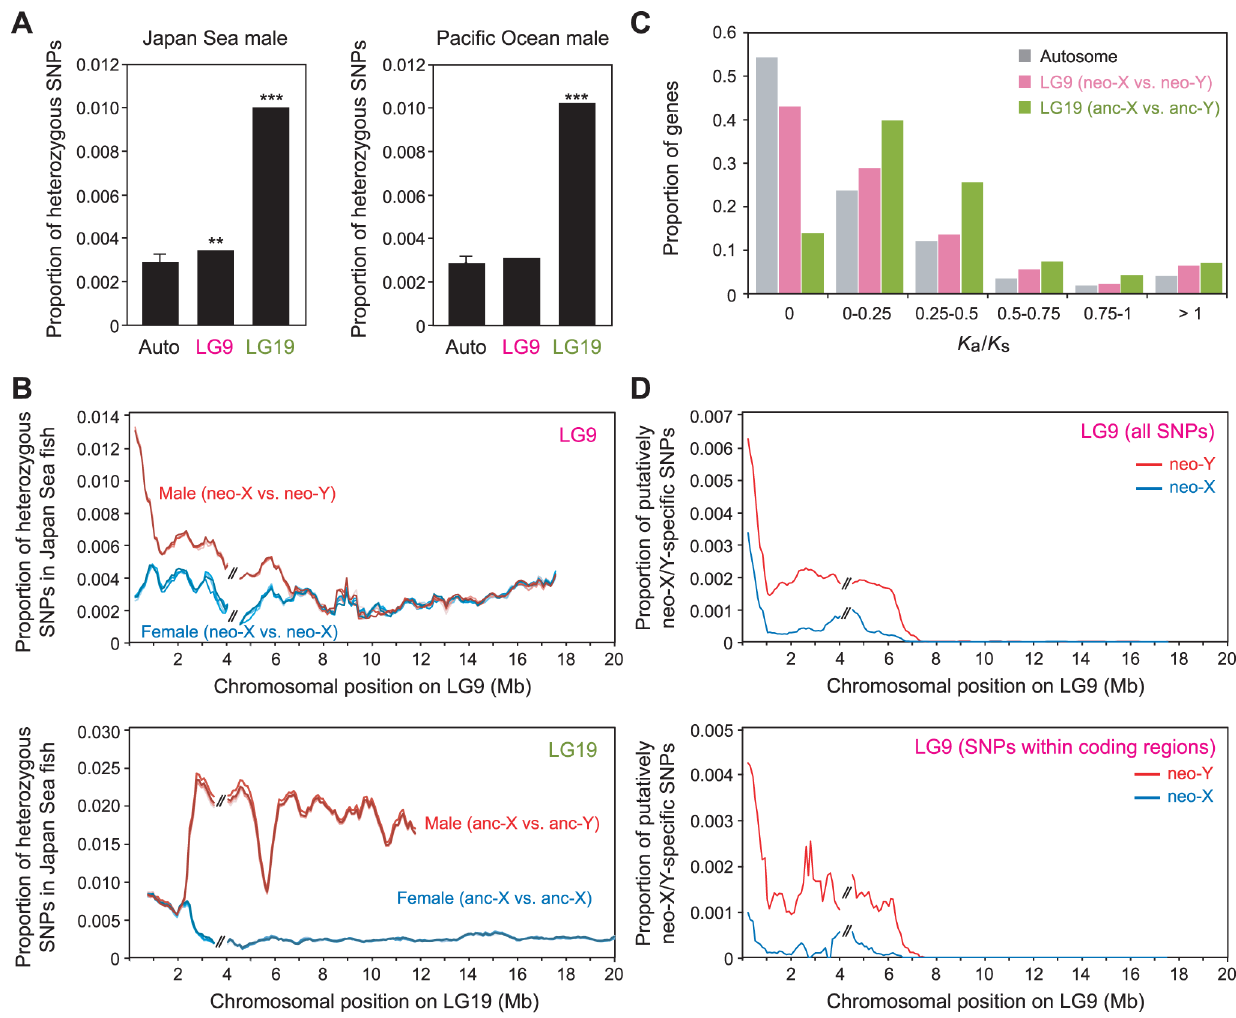
Figure 3. Nucleotide divergence between the Japan Sea neo-X and the neo-Y chromosomes. (A) Proportion of heterozygous SNPs in the Japan Sea male (left panel) and the Pacific Ocean male (right panel). A Grubbs’ outlier test was conducted to test whether LG9 and LG19 are outliers of all other linkage groups: **, P , 0.01, ***, P , 0.001. Data from one representative male of each species are shown here. For autosomes, means 6 S.E. are shown. (B) Sliding window analysis of the proportion of heterozygous SNPs in the Japan Sea male (red) and the Japan Sea female (blue) for LG9 (neo-sex chromosomes; upper panel) and LG19 (ancestral-sex chromosomes [anc-X and anc-Y]; lower panel). The window size and the step size were 500 kb and 100 kb, respectively. The two largest supercontigs were analyzed here, and the right one was inverted to provide the correct orientation as in Figure 2. The gap between these two supercontigs is indicated by // in the figure. Different colored lines indicate the five different Japan Sea males and the five different Japan Sea females. It should be noted that the scales on the Y-axis are different between the upper and lower panels. (C) Histogram of K a / K s between the Japan Sea neo-X and neo-Y chromosomes. (D) Sliding window analysis of proportion of putatively neo-X-specific (blue) and neo-Y-specific (red) SNPs among sequenced sites. The window size and the step size were 500 kb and 100 kb, respectively. The lower panel indicates only SNPs within coding regions.